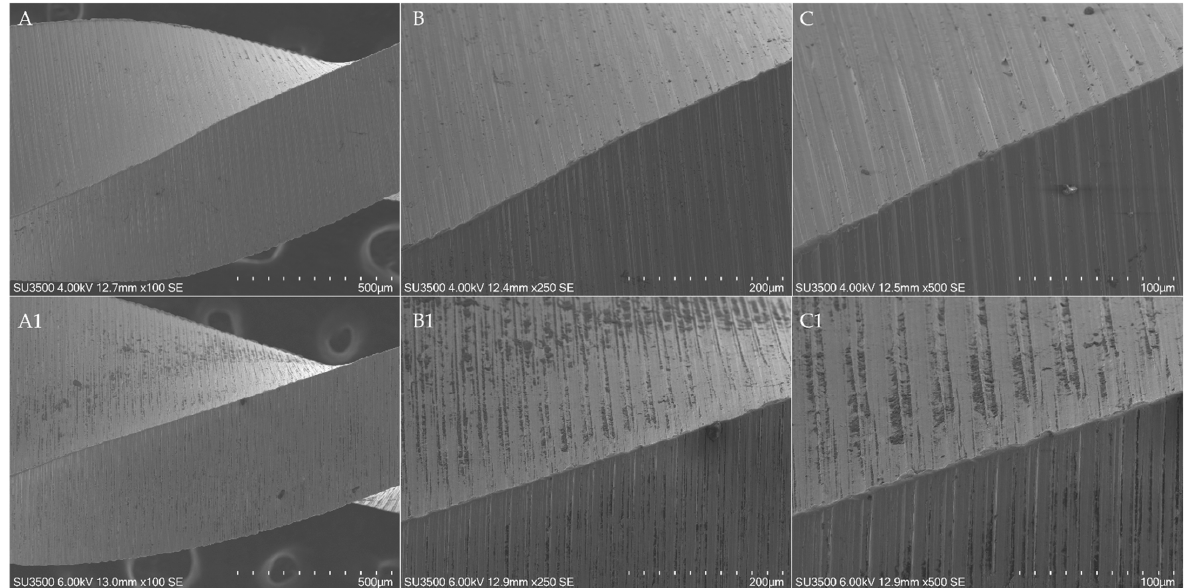
Figure 7. SEM images representing the limited flattening of cutting edges of WOG instrument after 4 simulated clinical uses at three different magnifications (from left to right respectively of ×100, ×250 and ×500). ( A – C ) cutting edge of WOG new instrument. ( A1 – C1 ) the same cutting edge of the WOG instrument acquired after 4 simulated clinical uses. A slight flattening can be appreciated only at ×500 magnification ( C , C1 ).